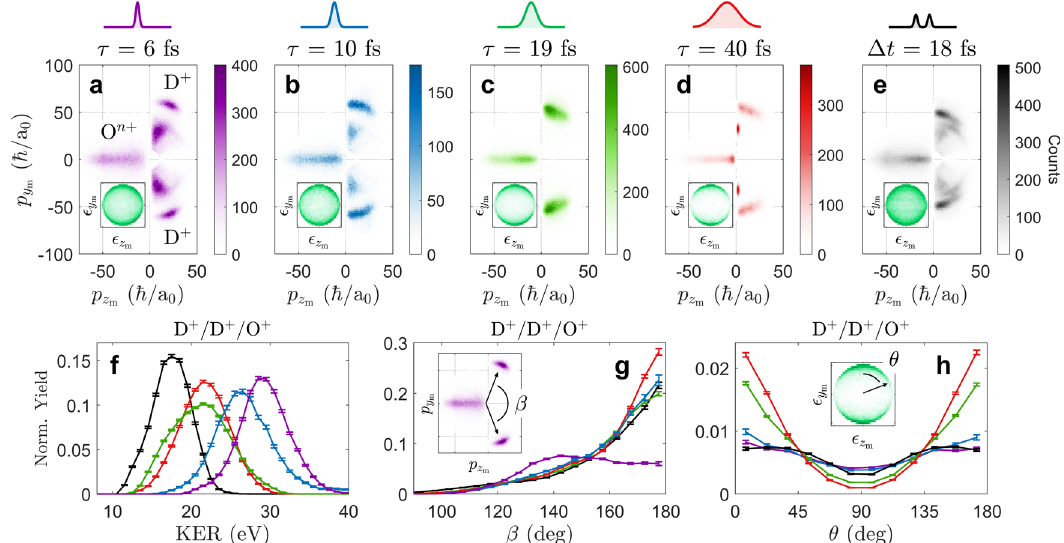
and p y ) of the three m m (cid:2) ^ ϵ Þ , for each D + / m